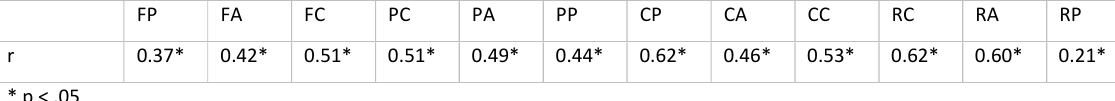
Table 3: Correlations between the corresponding Relational Ego states of therapist and client